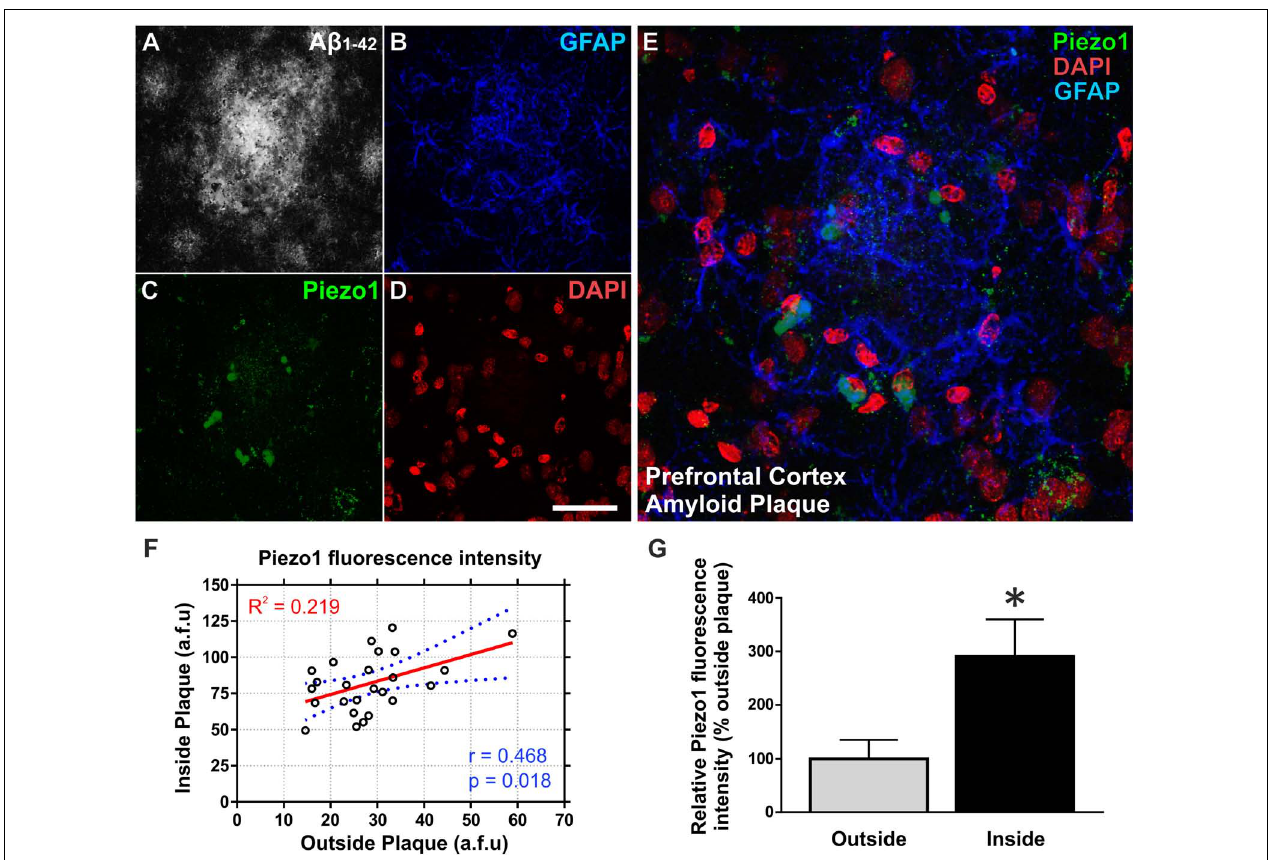
FIGURE 4 | A β 1 − 42 pathology in vivo upregulates Piezo1 expression in astrocytes surrounding amyloid plaques. 18-Month old TgF344-AD rat brains were immunofluorescently stained for (A) conformation-specific A β 1 − 42 , (B) GFAP, (C) Piezo1 (N-terminal antibody), and (D) DAPI. Scale bar = 40 µ m. (E) High magnification (100 × objective) z-stack projections of prefrontal cortex amyloid plaques reveal an upregulation of GFAP in reactive astrocytes surrounding the amyloid plaque. Piezo1 protein is also upregulated in a proportion of astrocytes in and around the core of the plaque. Piezo1 appears localized predominantly to the perinuclear compartment of A β 1 − 42 reactive astrocytes. (F) Astrocytic Piezo1 fluorescence intensity was calculated for astrocytes inside the amyloid plaque versus astrocytes located 200–500 µ m away from any noticeable plaque deposits. Piezo1 fluorescence intensity was averaged for six astrocytes “inside” and six astrocytes “outside” the plaque and 25 images from the frontal cortex of 18 m TG rats ( n = 6) were analyzed. There was no correlation (Pearson r = 0.468) between Piezo1 expression inside versus outside amyloid plaques. (G) However, on average there was a 190% increase in Piezo1 expression in astrocytes within the plaque